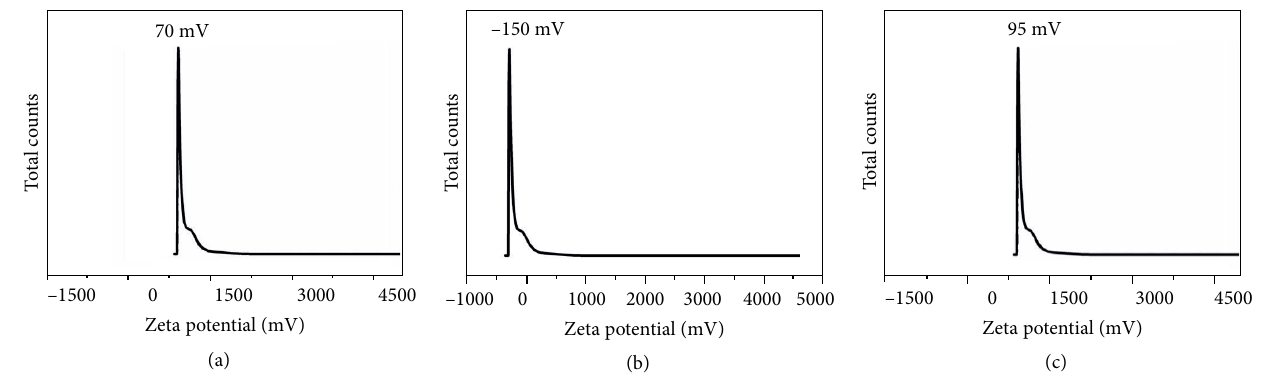
Figure 7: Expression of Zeta potentials of prepared nanomaterials. (a) Chitosan NPs, (b) TiO